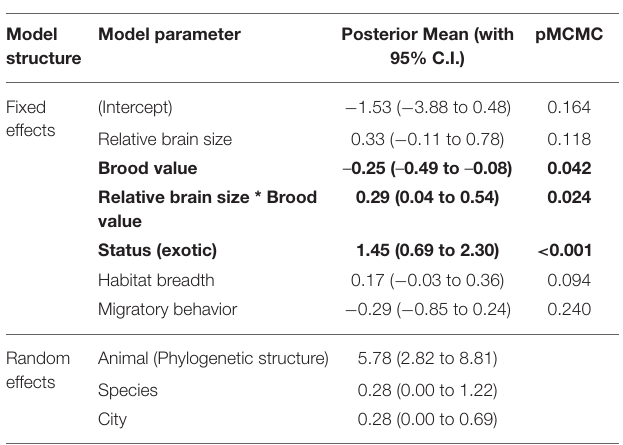
TABLE 2 | The effects of each predictor (Posterior mean with 95% credible interval) on the urban tolerance index, from a Phylogenetic Bayesian mixed model which includes the phylogenetic structure, species identity and city as random effects.